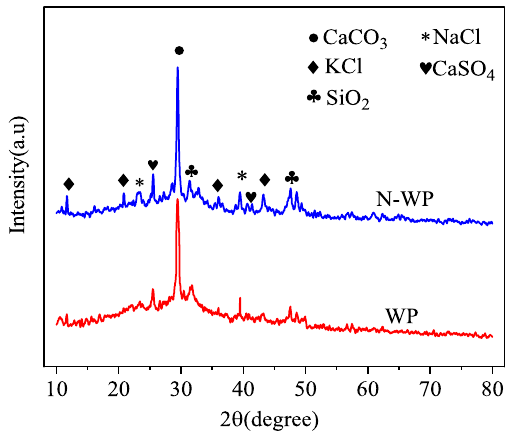
Figure 11. Influence of water washing pretreatment on crystal dosage of MSWI fly